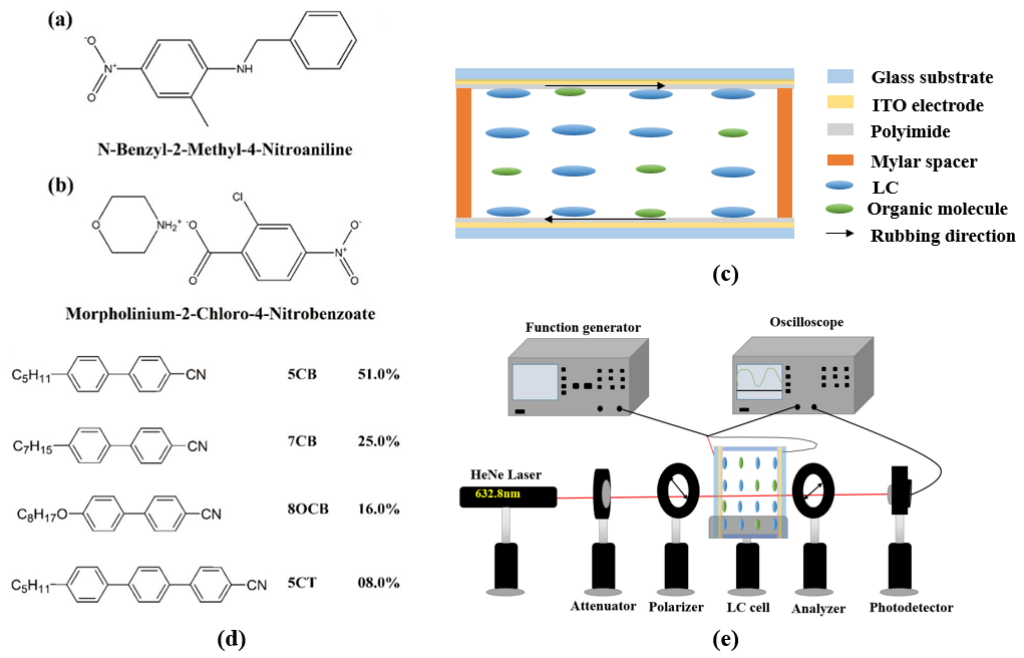
Figure 1. Molecular structures of ( a ) BNA, and ( b ) M2C4N. ( c ) Scheme of cell structure. ( d ) Molecular structure of LC E7. ( e ) Scheme of experimental setup for V-T curve measurement.